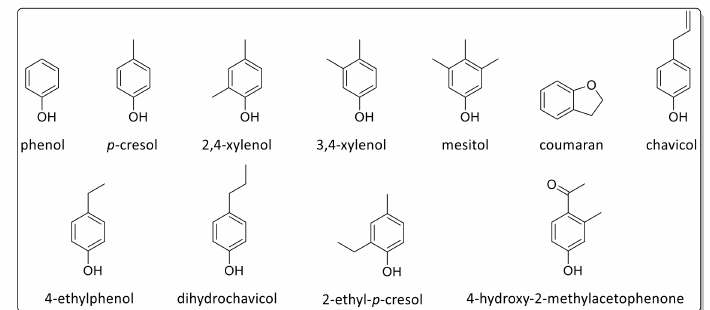
Figure 10. Detected Py-GC/MS fragments attributed to the H-unit.